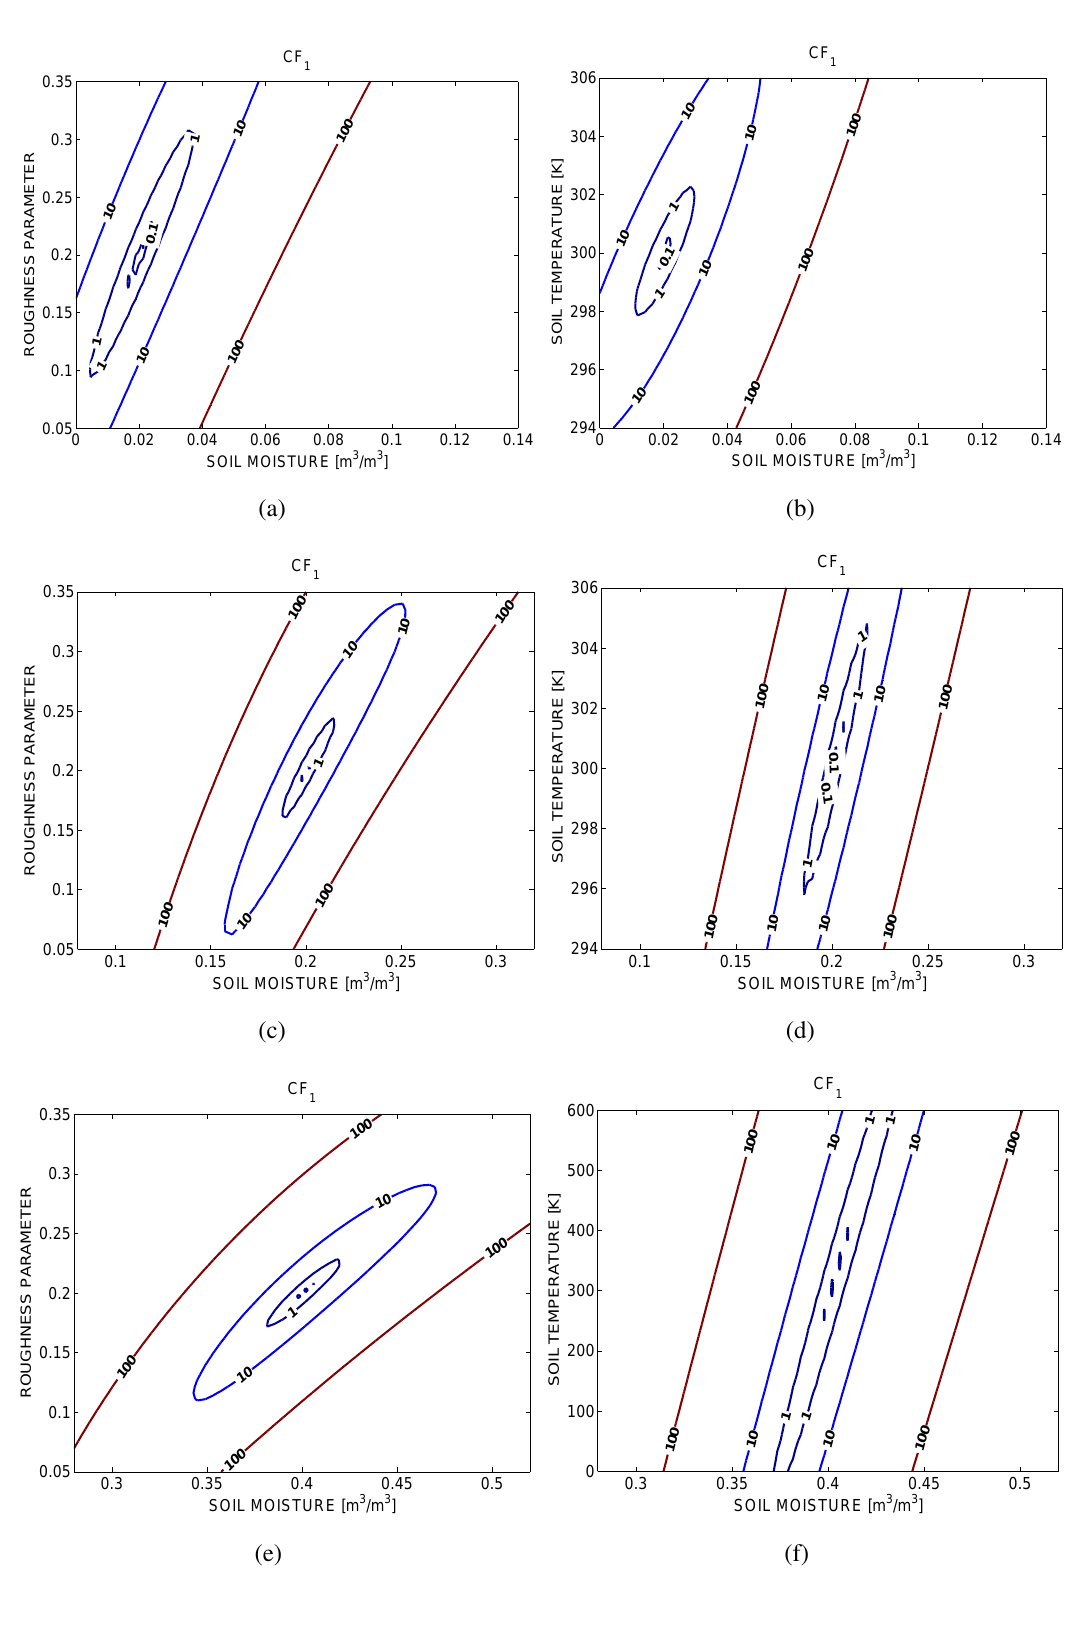
− T with no constraints. hh vv (a) and T vs s (b) over a bare dry soil scenario. m s m (c)and T vs s (d) over a bare moist soil scenario. m s m (e) and T vs s (f) over a bare wet soil m s m